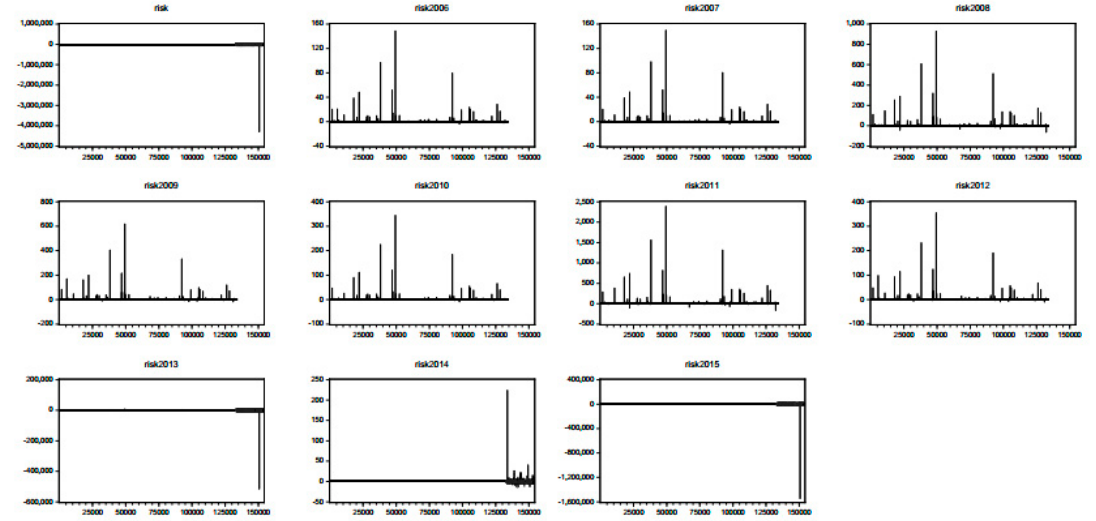
Figure 3. Plot of scoring bankruptcy risk by year. Source . Performed by the authors based on data provided by Amadeus database.